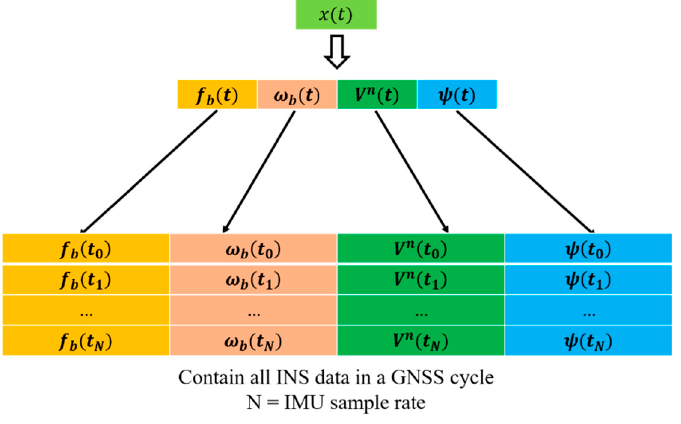
Figure 7. Input Figure 7. Input features.